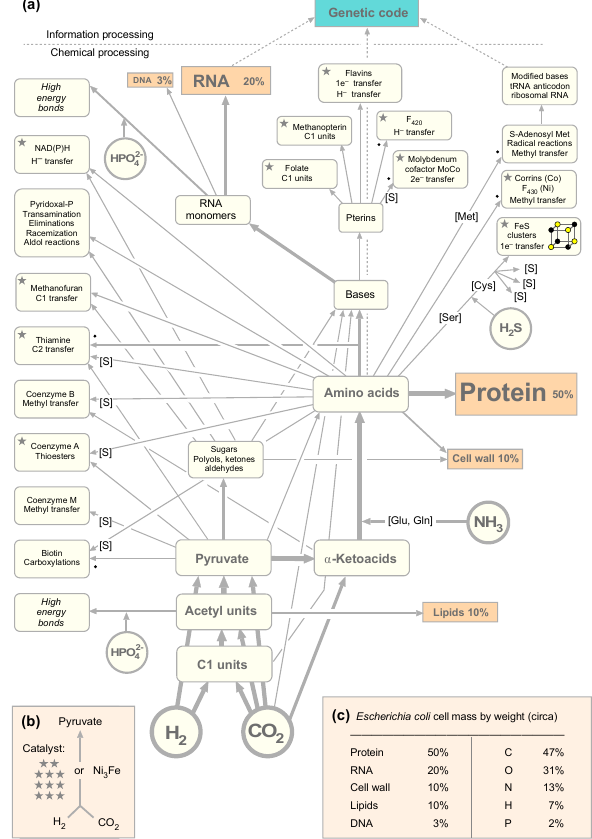
Figure 1. ( a ) A general map of core metabolism. The arrows in the map do not cover every atom in every cofactor, amino acid, or base, showing main mass contributions instead. A dot indicates that radical S-adenosyl methionine (SAM) enzymes are involved in the biosynthetic pathway leading to the product. [S] indicates that sulfur is incorporated in the biosynthetic pathway. ( b ) Cofactors indicated by a star are required in the pathway from H 2 and CO 2 to pyruvate in either acetogens or methanogens or both. ( c ) The composition of cells in terms of its main components and elemental contributions to dry weight (from [31]).